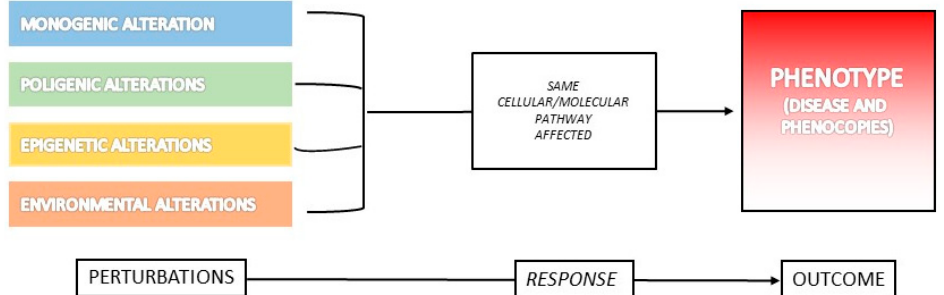
Figure 2. Mechanisms of disease convergence and generation of phenocopies. This picture illustrates the mechanisms responsible for the onset of overlapping clinical phenotypes, namely phenocopies. Monogenic, polygenic, epigenetic and environmental alterations can result in similar phenotypic traits, probably converging on the same functional pathway.